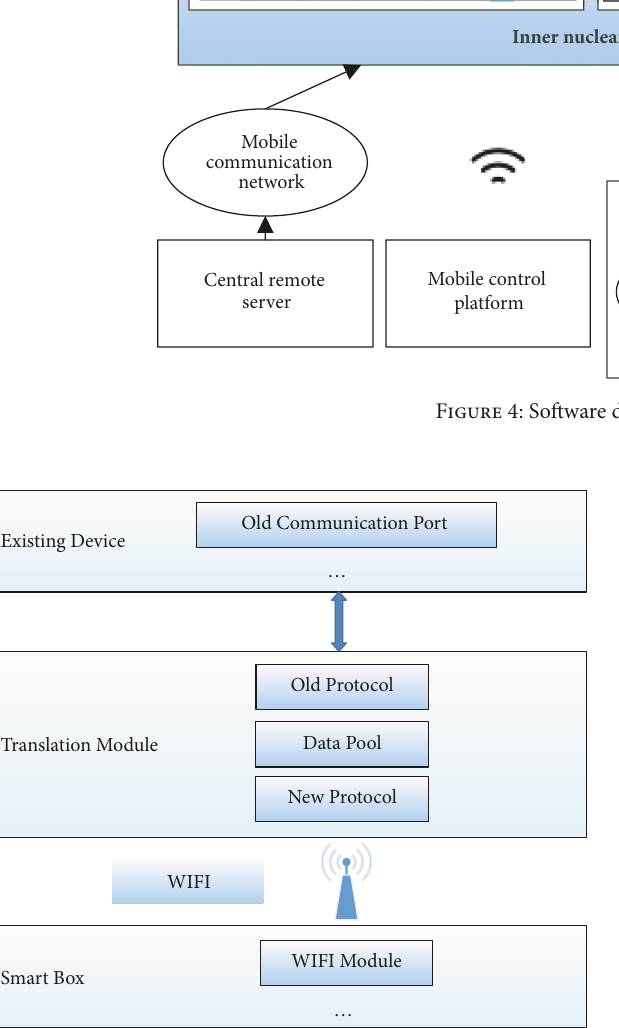
Figure 5: Modification of existing